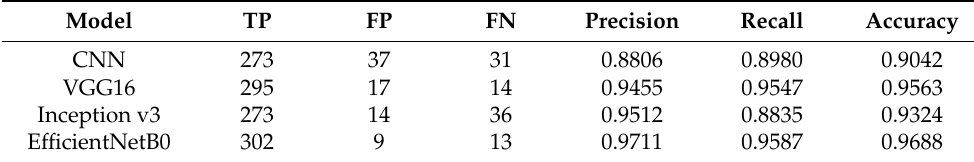
Table 2. Accuracy measurement in different